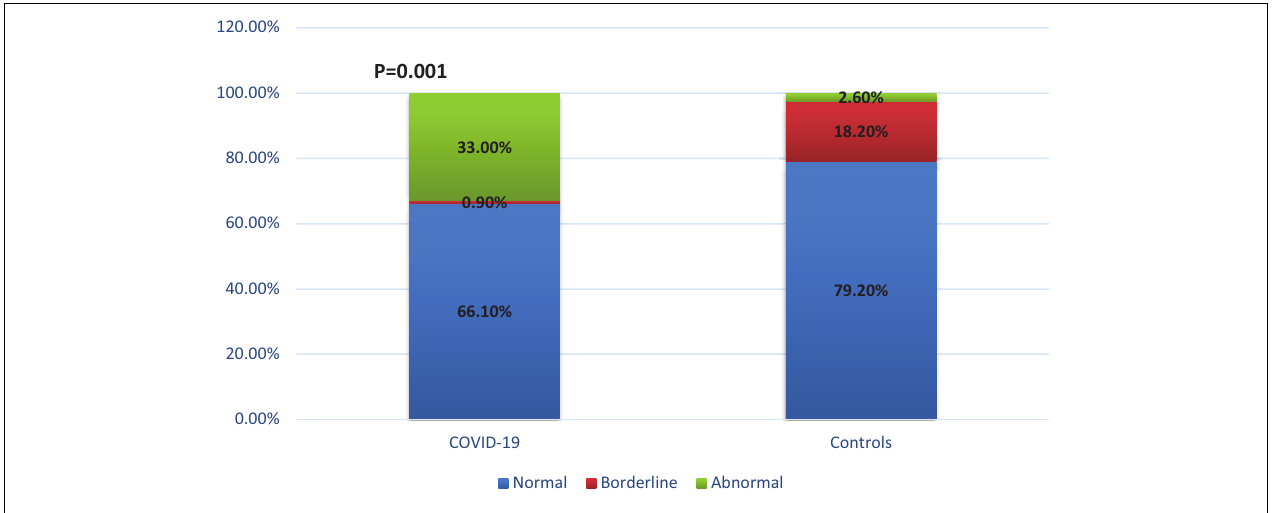
FIGURE 1 | Orthostatic hypotension in COVID-19. Results for COVID-19 patients are given in respect to both severe and mild group.